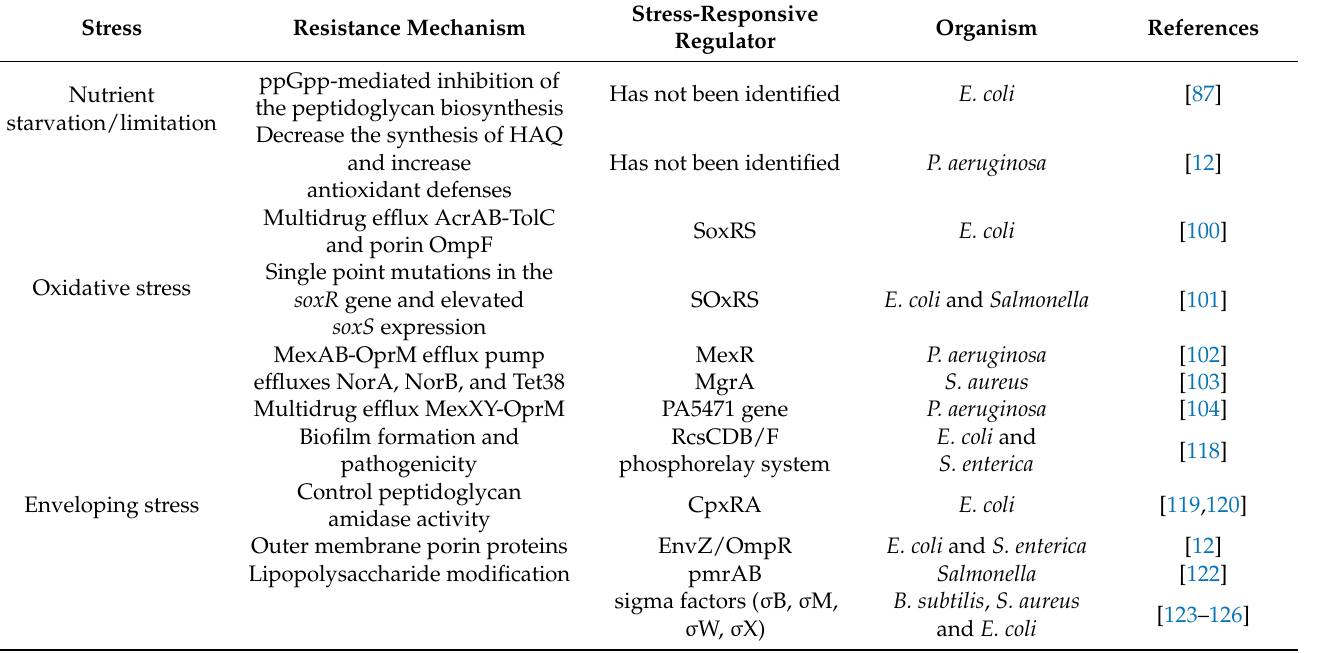
Table 5. Stress-inducible antimicrobial resistance